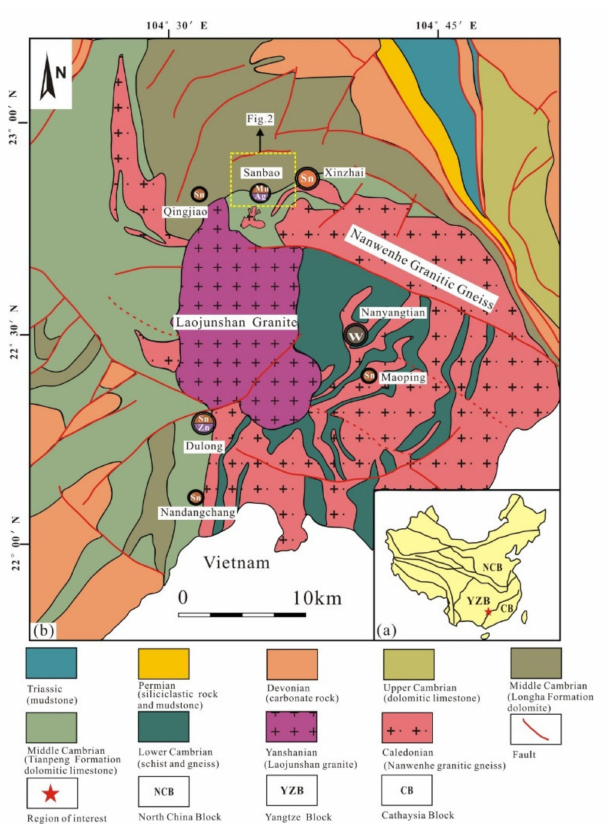
Figure 1. ( a ) The tectonic location of the Laojunshan ore district and ( b ) its geologic map (modified from